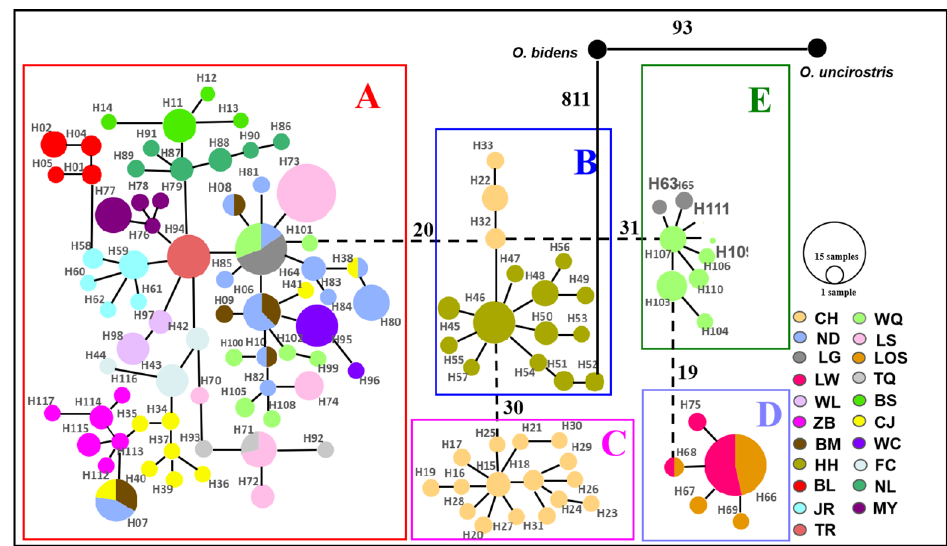
Figure 4. Minimum spanning network (MSN) of 117 haplotypes for O. hainanensis based on mitochondrial cyt b + D-loop genes identified in 305 individuals from 21 populations. Different colors indicate different sampling localities (see Figure 1). Circles represent haplotypes, and the proportion size is proportional to the number of individuals represented. Single lines directly connecting haplotypes indicate separation by one mutation step. The number of vertical bars on the connecting line is an increasing number of mutation steps. Clades A–E is shown on the map with corresponding colors for each lineage. O. bidens and O. uncirostris are two species in the genus Opsariichthys used as an outgroup.